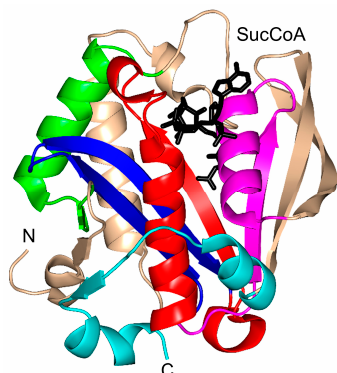
Figure 16. Cartoon representation of the structure of putative M. tuberculosis succinyltransferase (Rv0802c) in complex with succinyl CoA (PDB ID: 2VZZ [4]). The conserved and